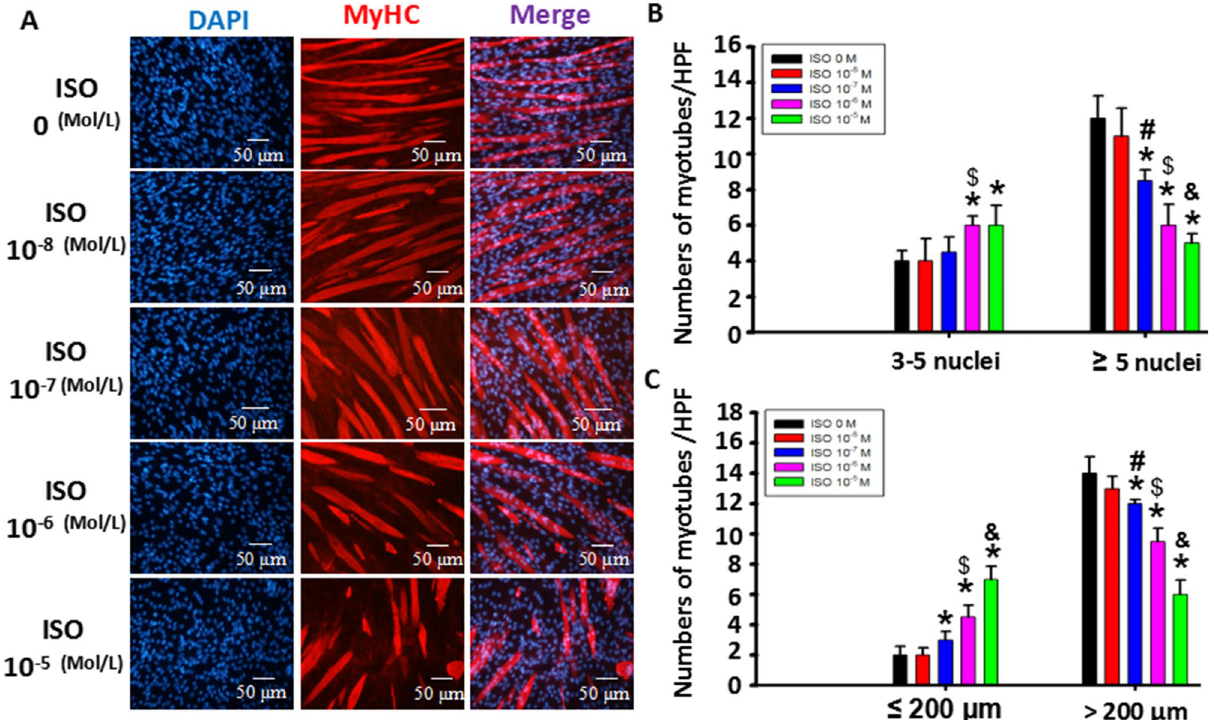
Figure 2. Continuous ISO stimulation dose-dependently altered NFATc1 and NFATc2 signaling. ( A ) Typical image of MyHC staining in differentiated C2C12 myoblast cells exposed to continuous single-dose 10 −5 M ISO. ( B ) A quantitative assay for the number of MyHC + myotubes with 3–5 or more than 5 nuclei was performed six days after myoblast differentiation following stimulation with ISO delivered with a continuous single dose. n = 3, *P < 0.05 versus Ctrl; $ P < 0.05 versus 10 −8 M ISO or 10 −7 M ISO; # P < 0.05 versus 10 −8 M ISO; & P < 0.05 versus 10 −8 M ISO or 10 −7 M ISO. ( C ) Quantitative assays for the number of MyHC + myotubes with lengths of less than 200 μm or more than 200 μm were performed six days after myoblast differentiation following stimulation with ISO delivered with a continuous single dose. n = 3, *P < 0.05 versus Ctrl; $ P < 0.05 versus 10 −8 M ISO or 10 −7 M ISO; # P < 0.05 versus 10 −8 M ISO; & P < 0.05 versus 10 −8 M ISO, 10 −7 Mor1 0 −6 M